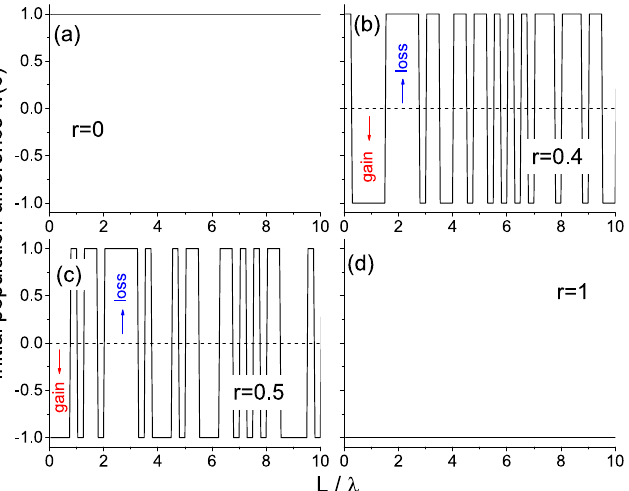
Figure 1. The example of initial population difference distributions for different disorder strengths r .